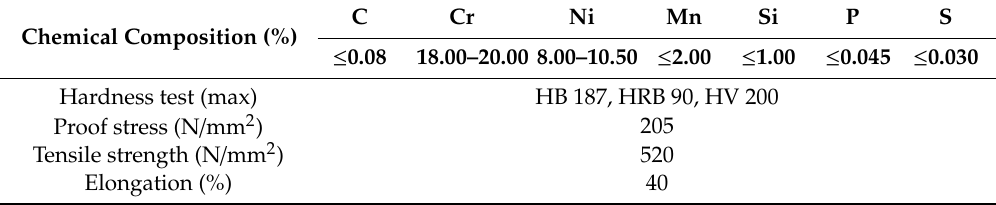
Table 2. The chemical composition and properties of SUS304 austenitic stainless steel